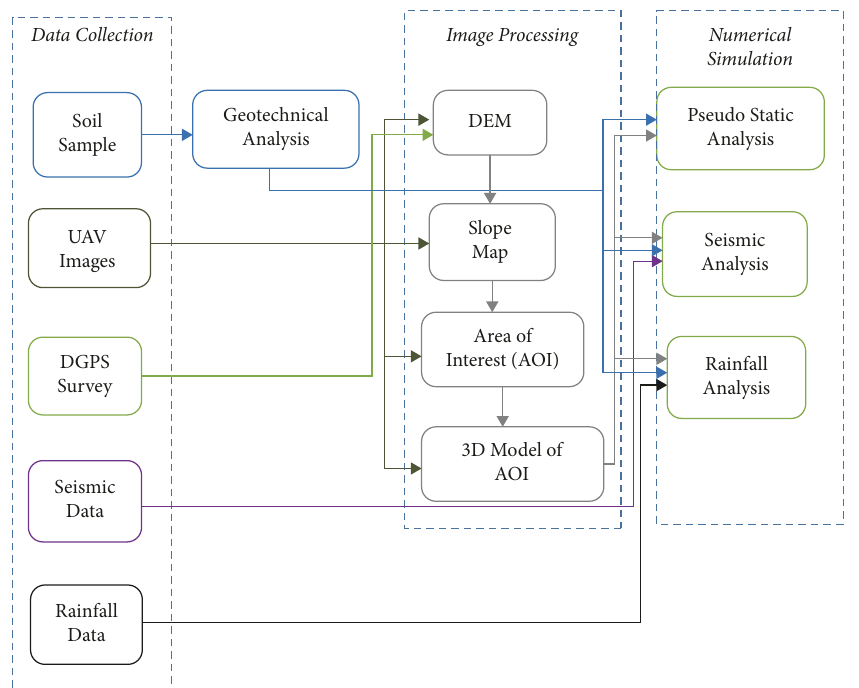
Figure 3: Slope stability analysis method in static, seismic, and rainfall conditions with the